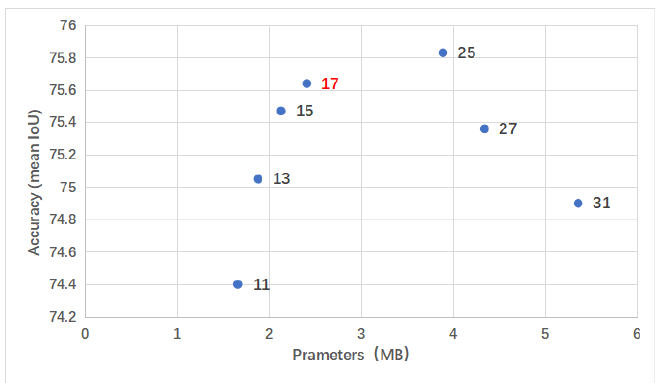
Figure 4. The accuracy and model size vs. the kernel size. A good trade-off was obtained when the kernel size was 17 ×